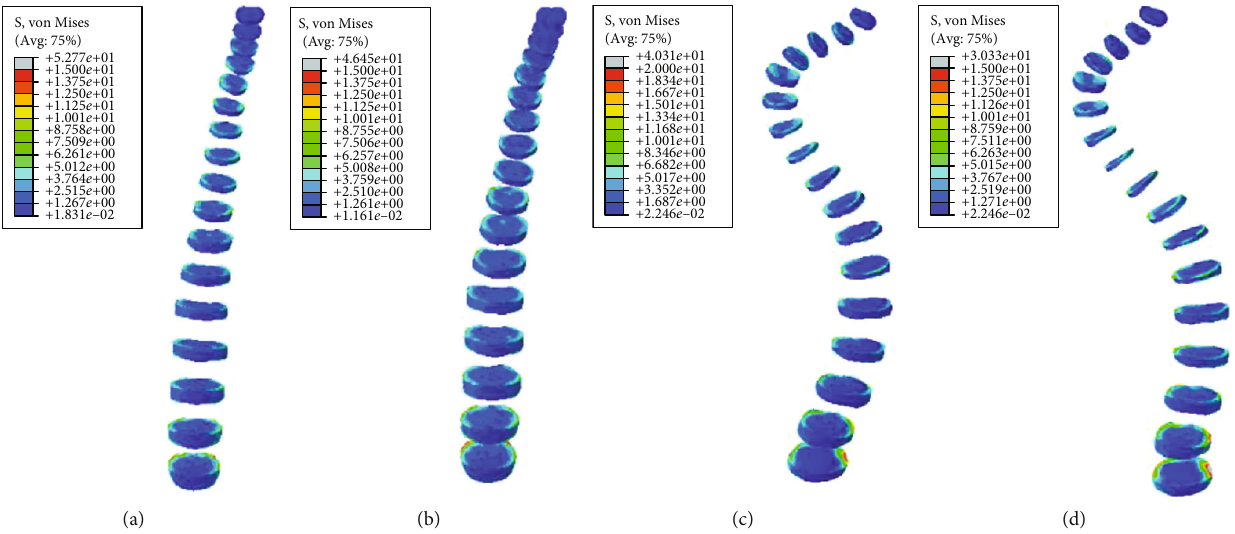
Figure 4: von Mises stress distribution of discs in four spinal models with left curvature: (a) normal spine without rib cage (NS1); (b) normal spine with normal rib cage (NS2); (c) scoliotic spine without rib cage (SS1); (d) scoliotic spine with deformed rib cage